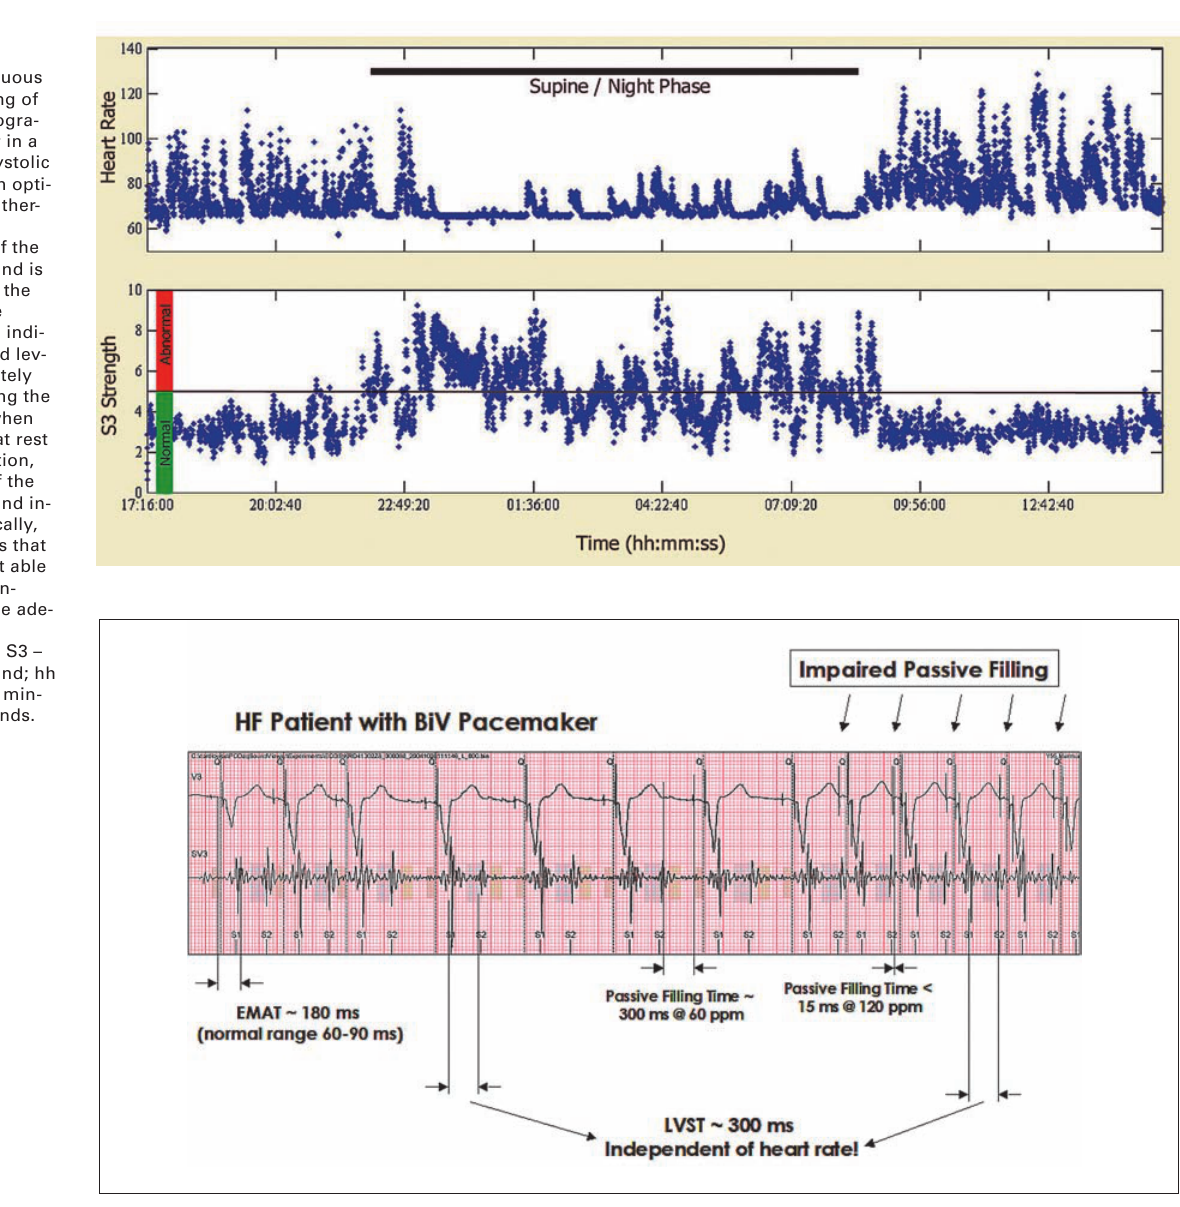
Acoustic cardiography recording on a subject with a biventricular pacemaker at two different pacing rates. The figure illustrates that the selection of the appropriate base rate or the rate-adaptive for a pacemaker patient with